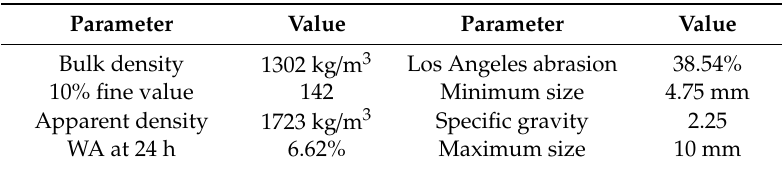
Table 1. Di ff erent properties of recycled